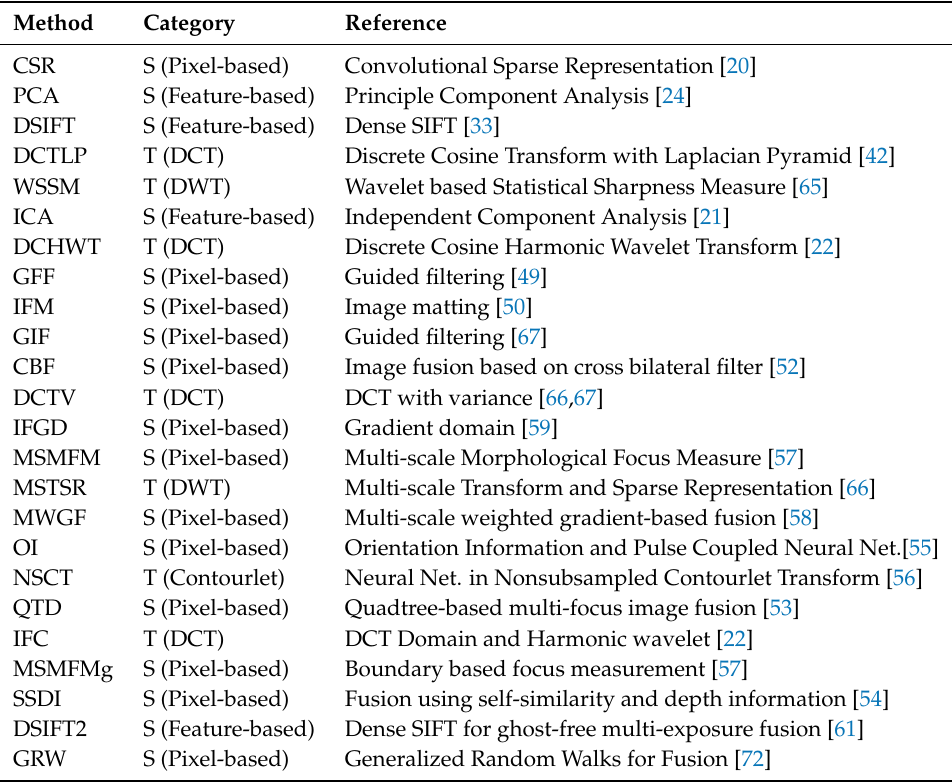
Table 1. List of multi-focus image fusion (MIF) algorithms used in this study. Category represents the category of the algorithm: S for spatial and T for transform domain-based method, the the sub-category of the algorithm is provided in